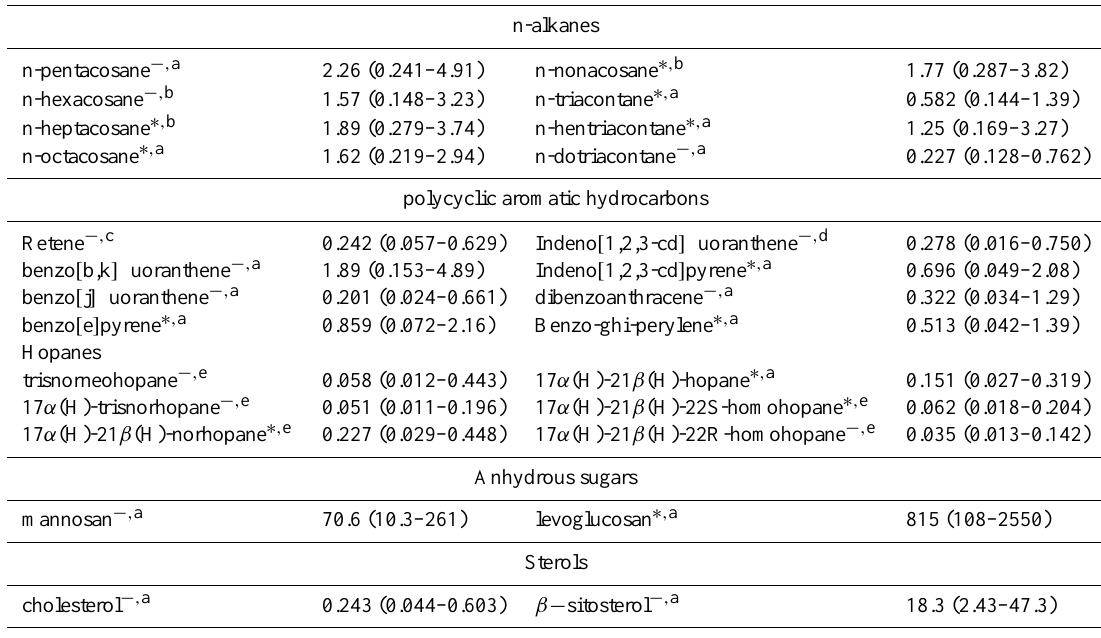
Table 1. Organic marker concentrations (ngm − 3 ) in PM 2 . 5 – average